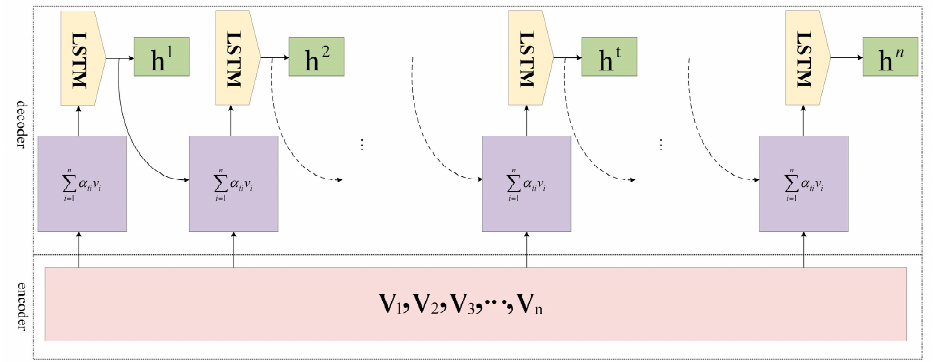
Figure 4. Attention-based LSTM model.